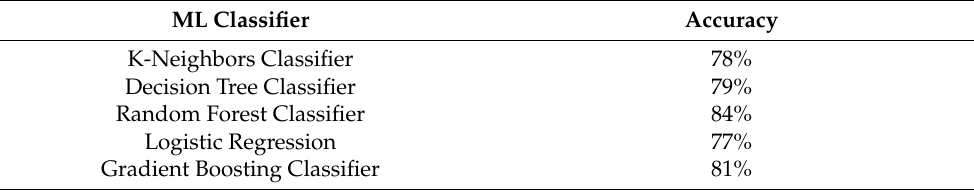
Table 5. Accuracy of various ML models in a three-value thermal comfort scale.